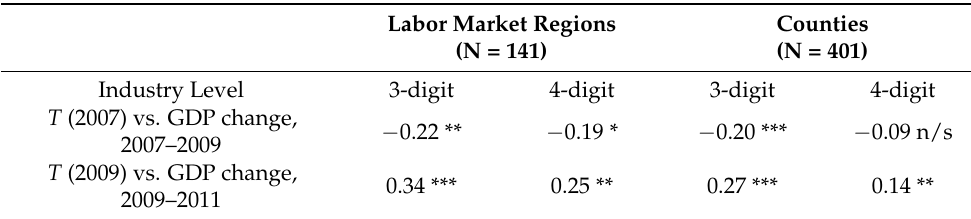
Table 2. Correlation coefficients between an area’s tightness T in 2007 and 2009 and the area’s change in GDP per worker over the subsequent two years. Correlations are presented for two types of spatial units and for both 3-digit and 4-digit industry levels of employment aggregation. Labor Market Regions Counties (N = 141) (N = 401) Industry Level 3-digit 4-digit 3-digit 4-digit T (2007) vs. GDP change, − 0.22 ** − 0.19 * − 0.20 2007–2009